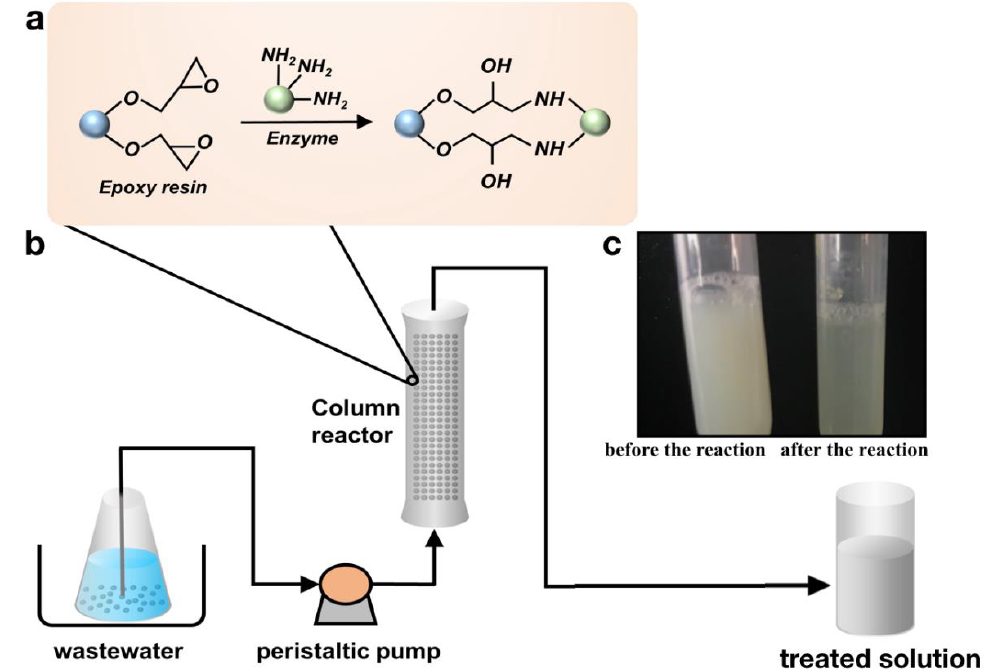
Figure 5. A schematic of the packed-bed bioreactor for the biodegradation of bifenthrin. ( a ) Est M160K immobilization on epoxy resin lx-105s. ( b ) Experimental set-up of packed bed reactor (PBR) used for continuous degradation of bifenthrin wastewater by lx-Est M160K . ( c ) Picture of samples before and after degradation of bifenthrin wastewater by lx-Est M160K .